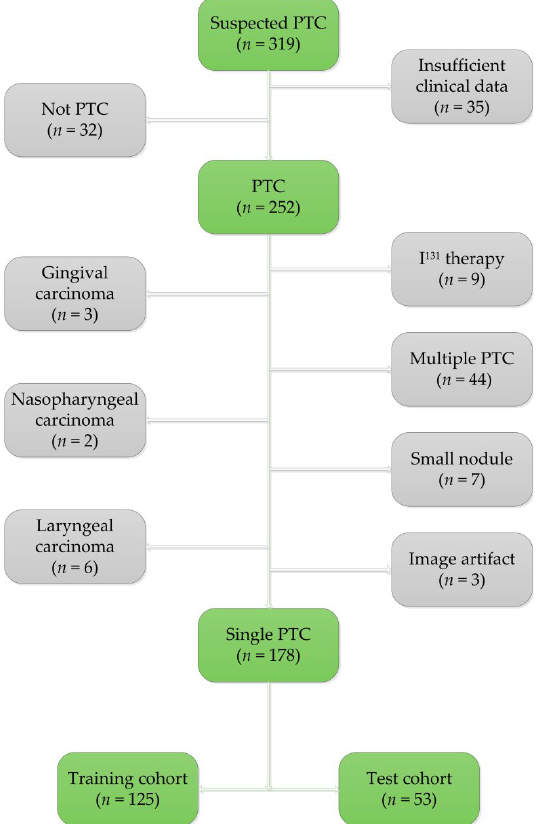
Figure 1. Exclusion criteria and details of the patients in the training and test